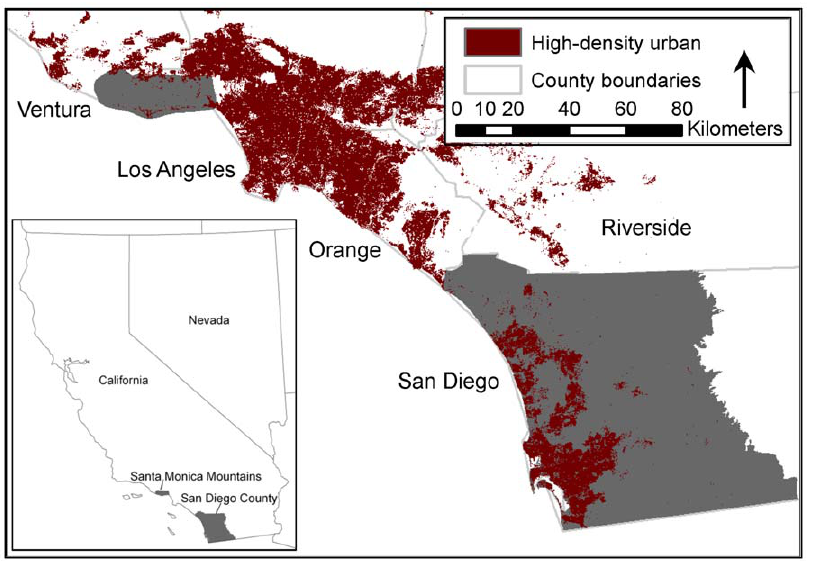
Figure 1. The Santa Monica Mountains and San Diego County, California, USA. Study areas in gray. The Santa Monica Mountains are located in Ventura and Los Angeles counties, and both study areas are located within the South Coast Ecoregion of California, USA. Study areas in gray.